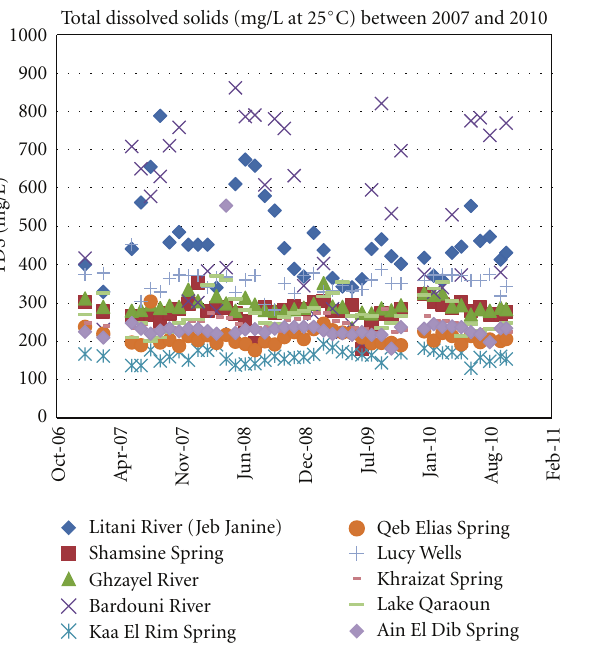
Figure 5: Electrical conductivity values for years 2007 through